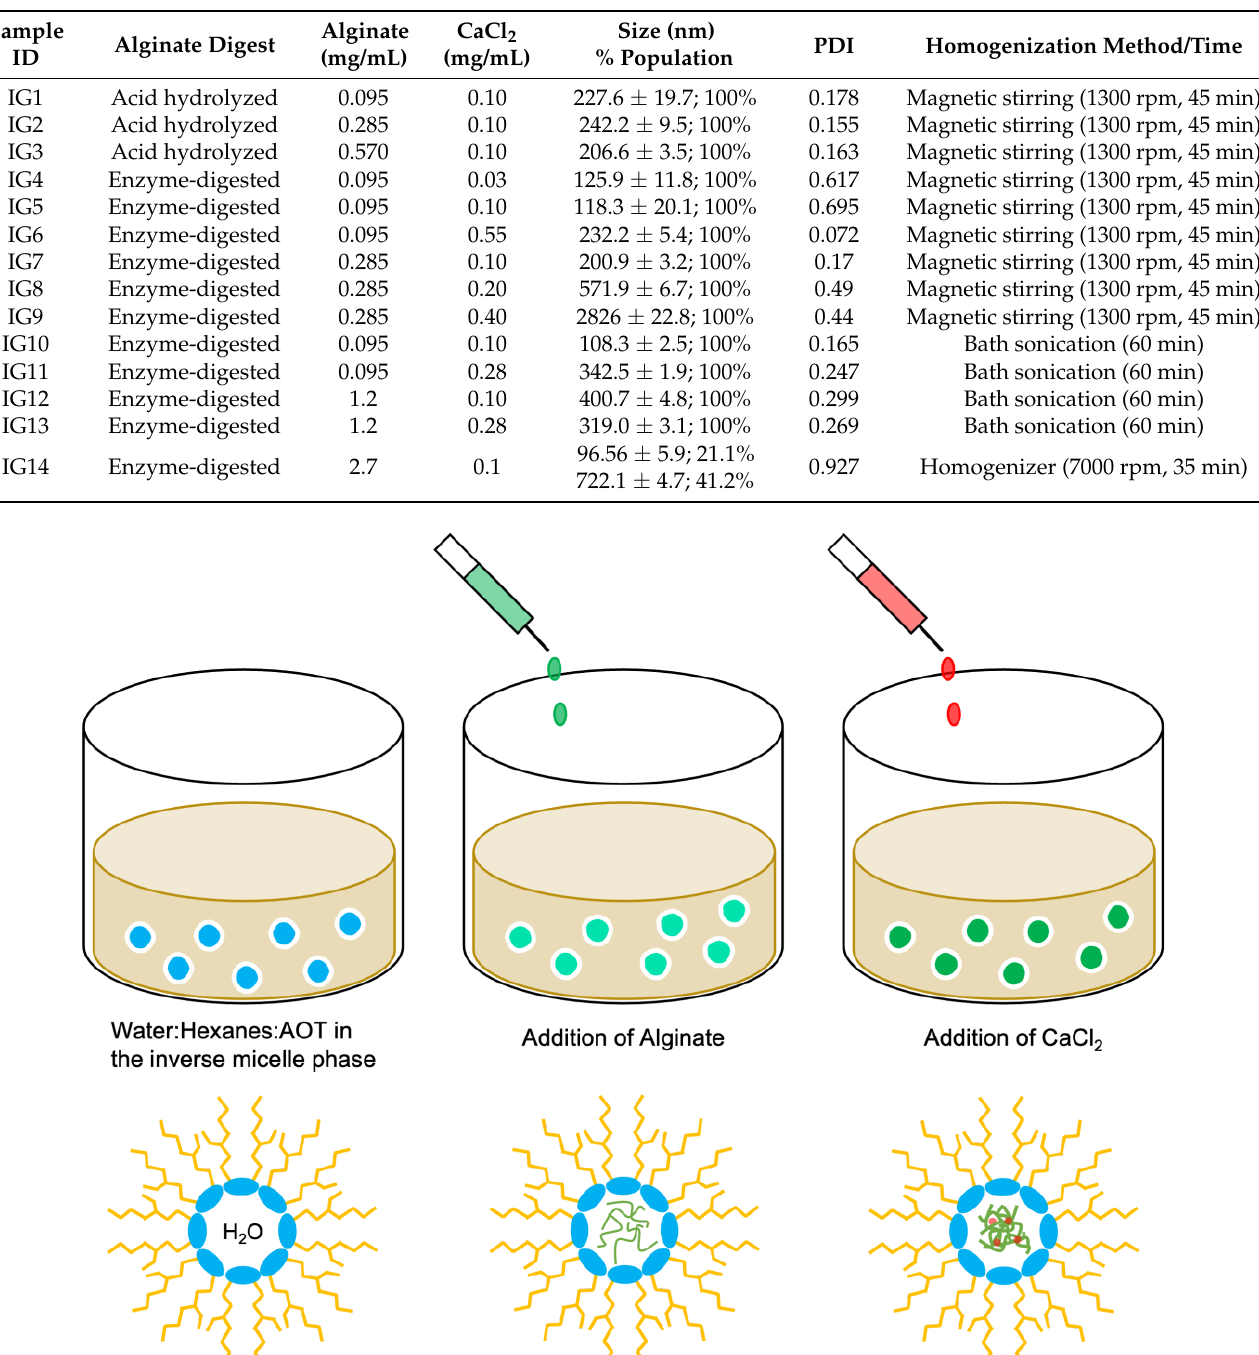
Table 1. Experimental parameters and results of the alginate nanoparticle synthesis by ionic gelation. Final alginate and CaCl 2 concentrations are provided.